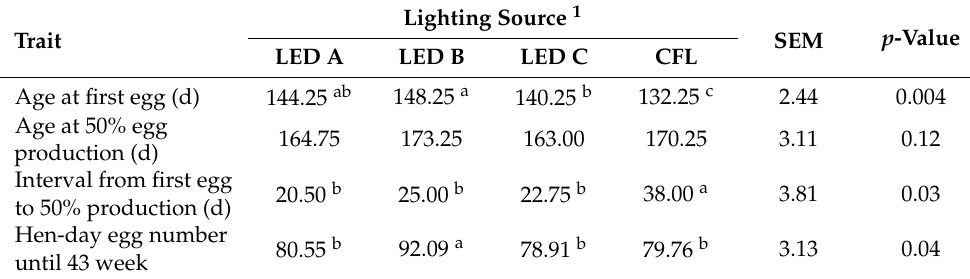
Table 6. Effect of lighting sources on egg production of Beijing-You